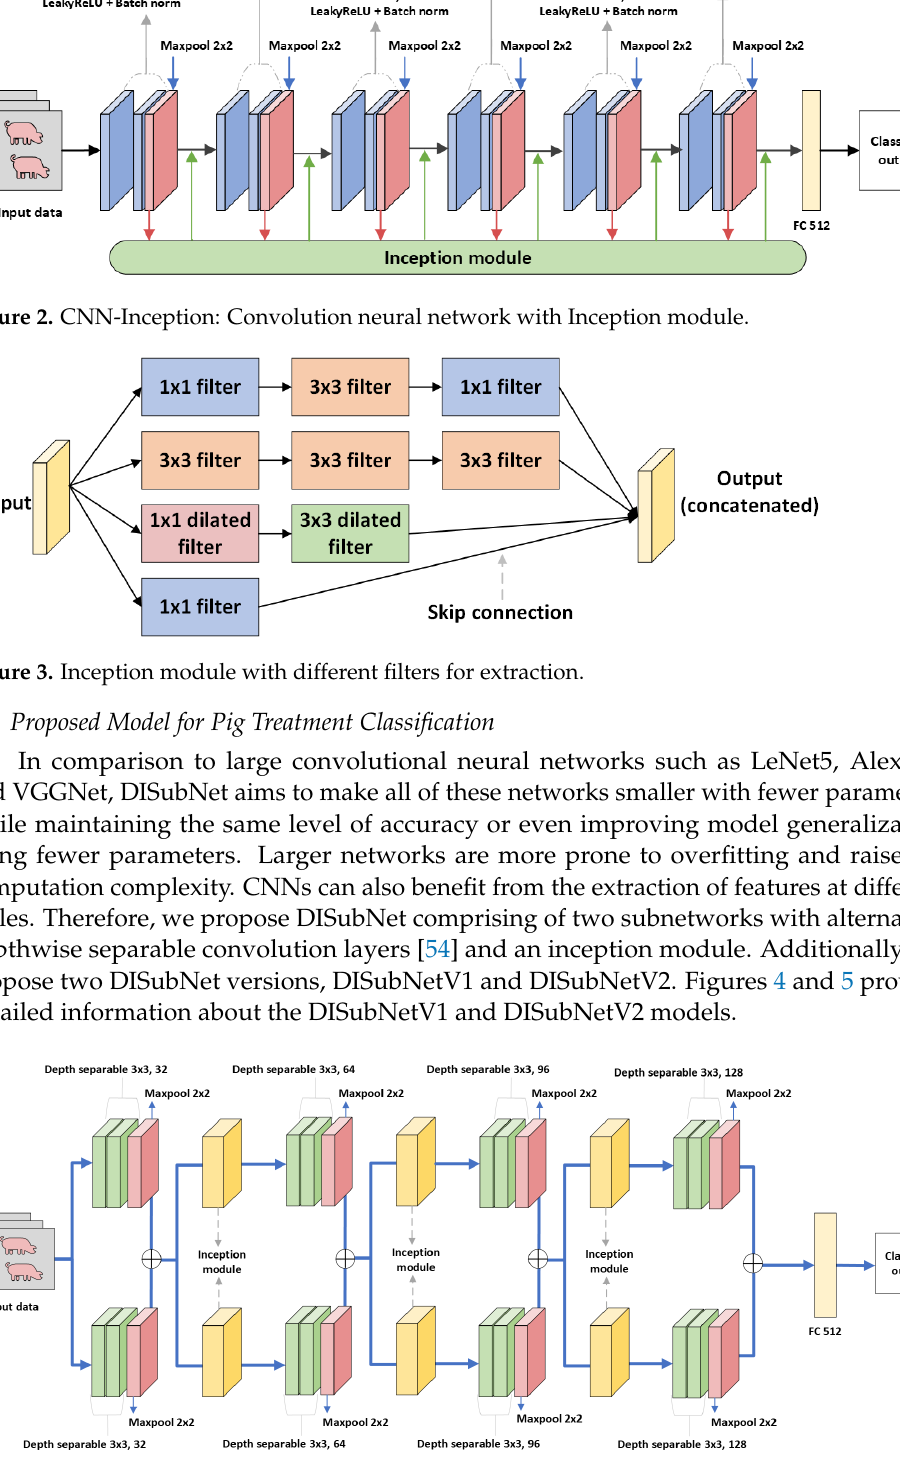
Figure 4. DISubNetV1: Depthwise separable convolution with inception module subnetwork. The output from depthwise layers is concatenated in this model and fed into the inception module for further